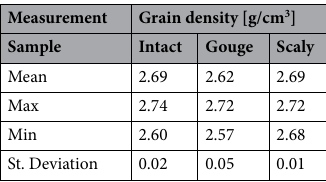
Table 3. Grain density results of intact, scaly clay and fault gouge Opalinus Clay